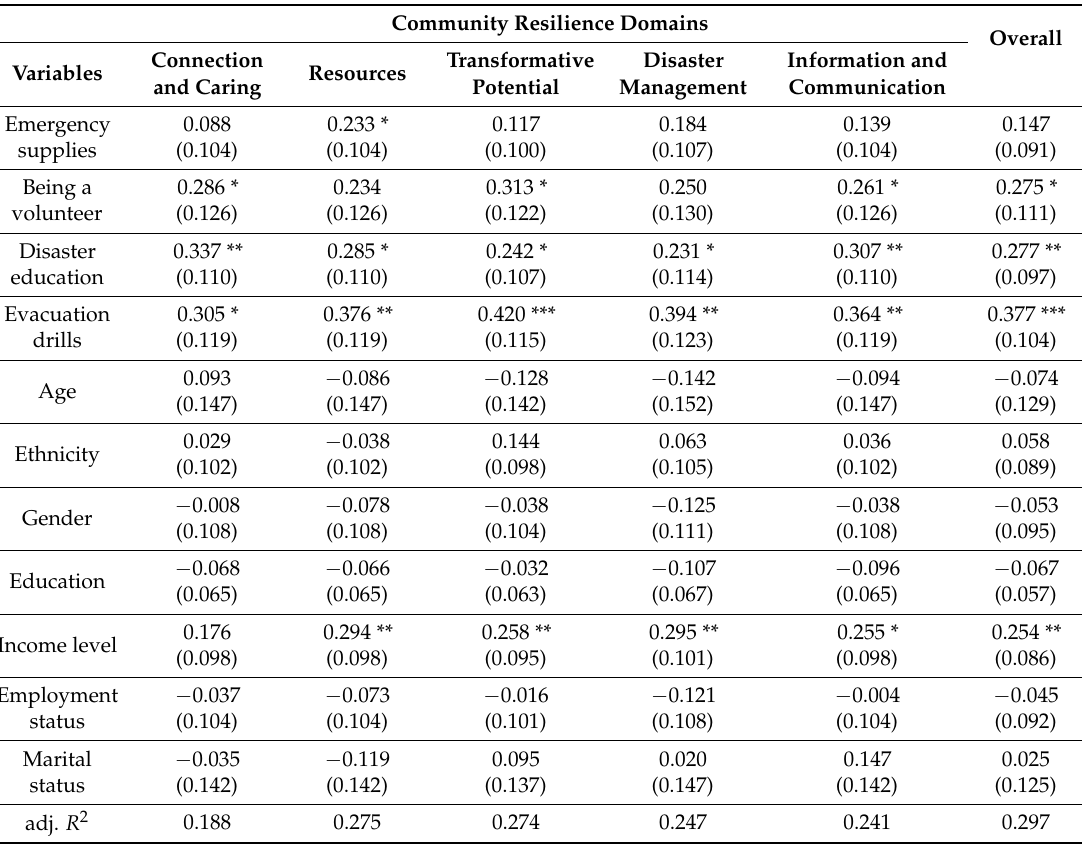
Table 3. Linear regression results for community